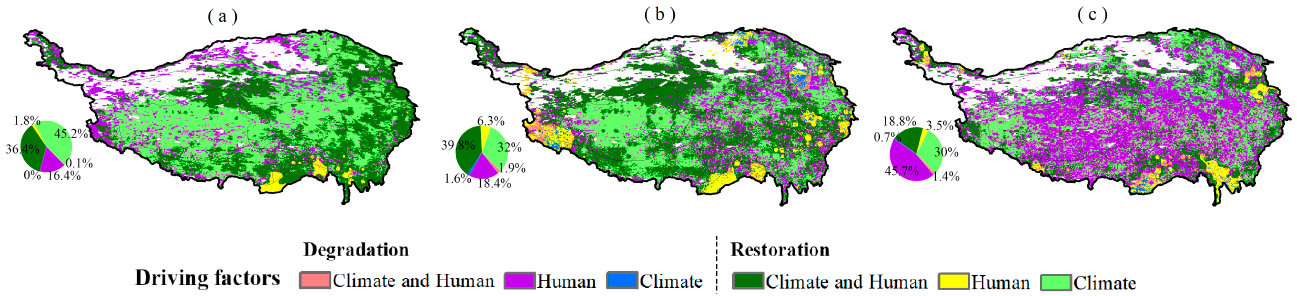
Figure 8. Driving factors of vegetation change on the QTP in 1982–2019; ( a ) 1982–2019; ( b ) 1982–2000; and ( c ) 2001–2019.